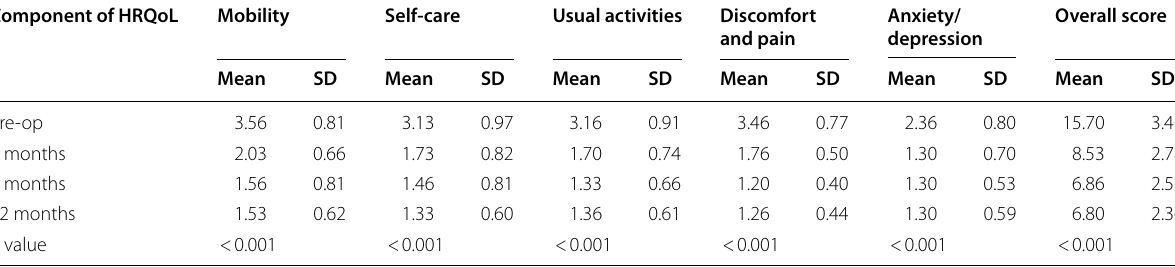
Table 2 Changes in mean score of five components of HRQoL over time Component of HRQoL